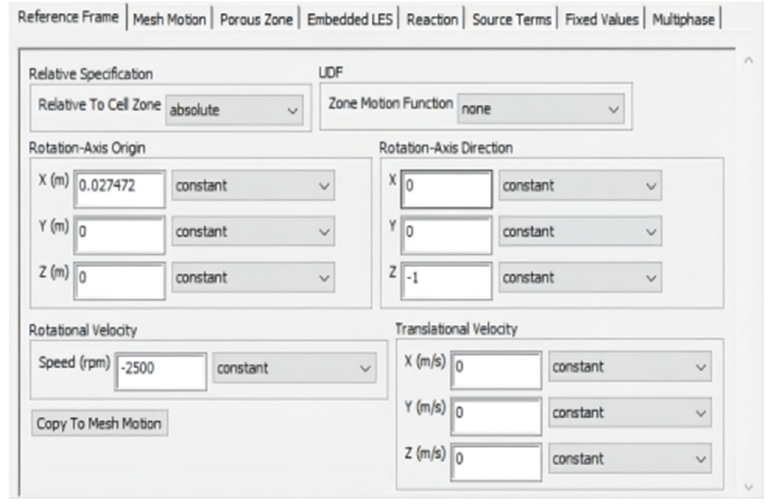
Figure 8. Settings of the cell zone conditions.